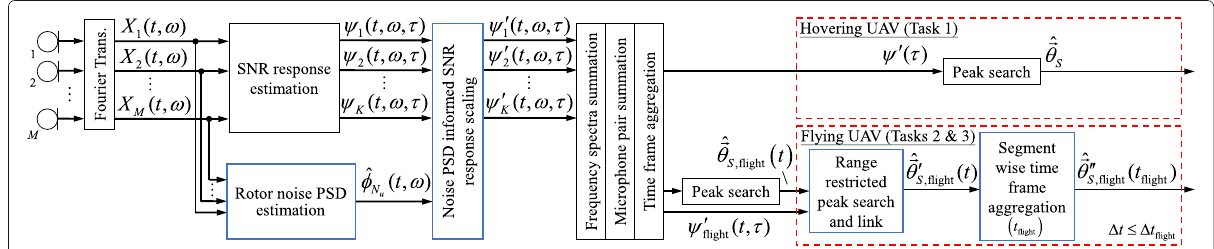
Fig. 2 Block diagram of the proposed method. Blue boxes indicate modifications to [27] introduced by the proposed method. Processes in the boxes with red dashed line are selected based on the scenario (i.e. hovering or flying UAV)